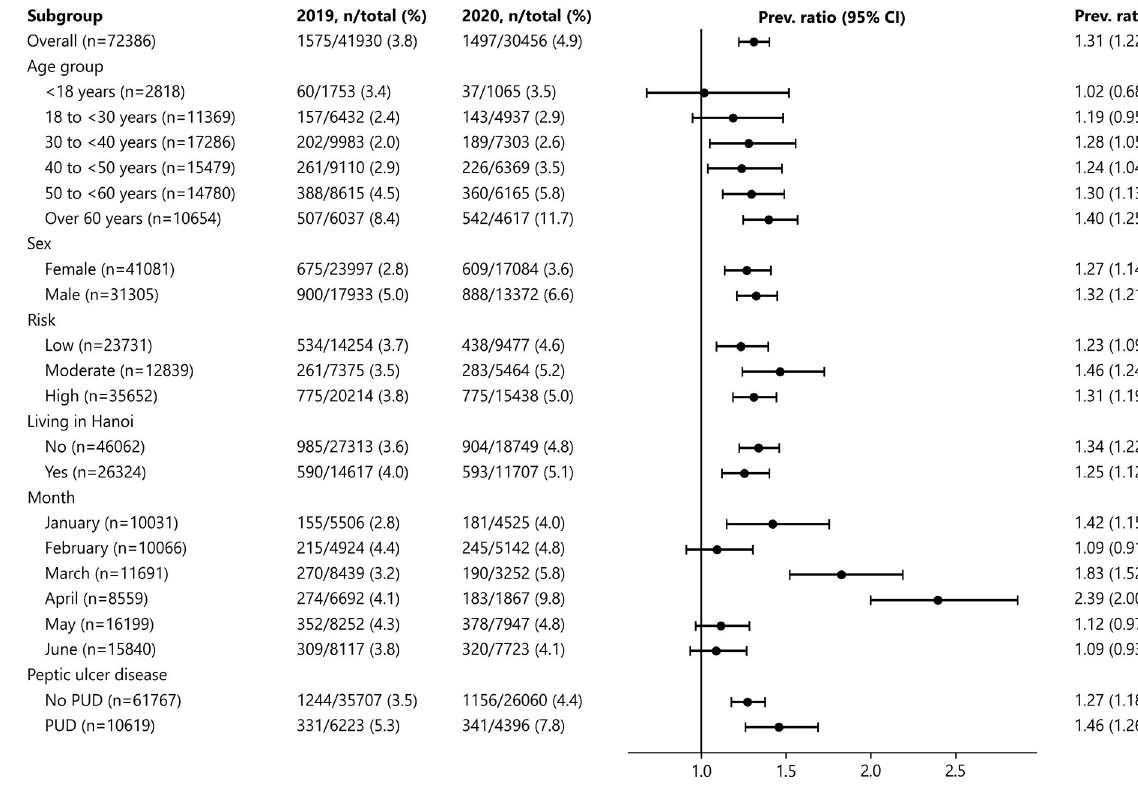
Vietnam. The number of new COVID-19 cases peaked in late March, marking the beginning of the nationwide distancing on April